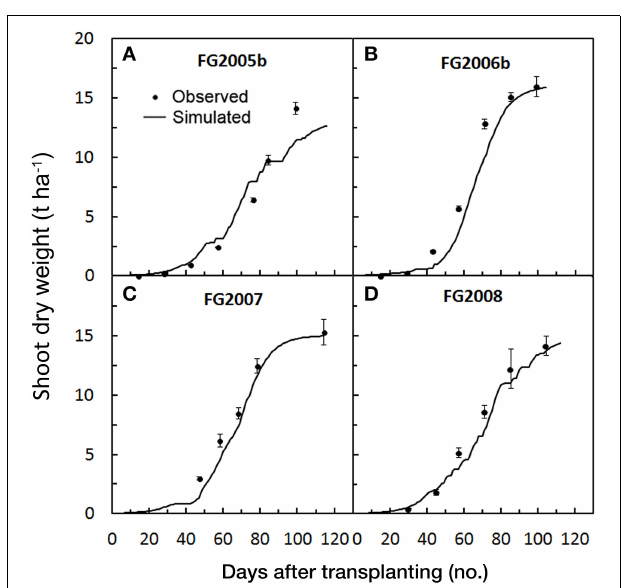
FIGURE 4 | Simulated and observed SDW accumulation during the four tomato cycles in Foggia [FG2005b (A), FG2006b (B), FG2007 (C), FG2008(D)], used for validating GesCoN . Mean standard errors, when larger than the symbol, are represented by vertical bars.